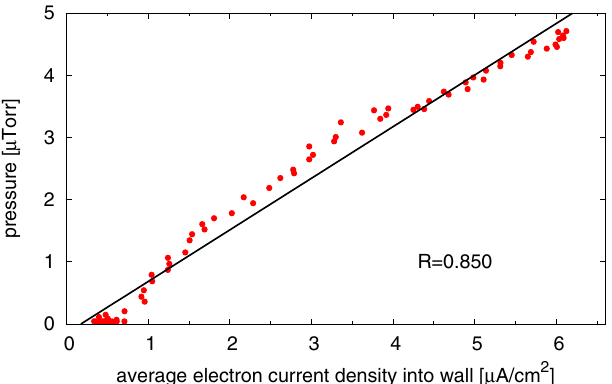
FIG. 10. (Color) Pressure increase vs time-averaged electron current density into the wall. Red dots are measured values, the black line is a linear fit [21,22].